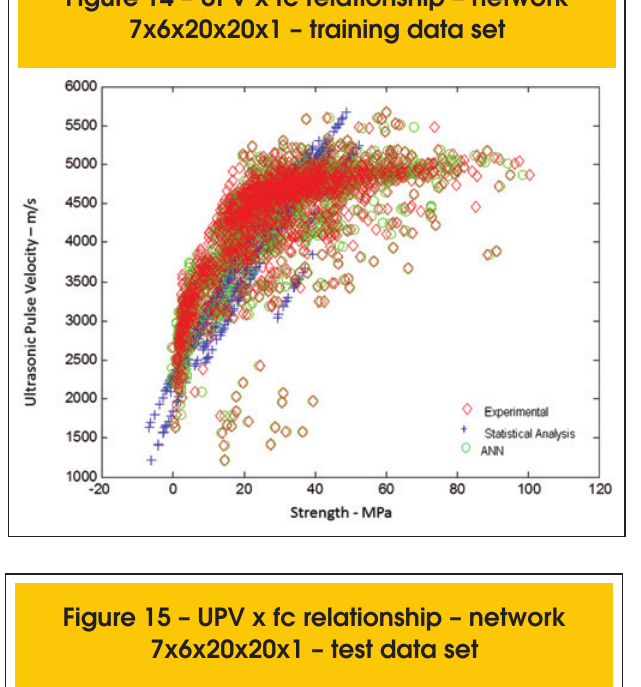
Figure 18 – UPV x fc x w/c ratio relationship – network 7x6x20x20x1 – Training data